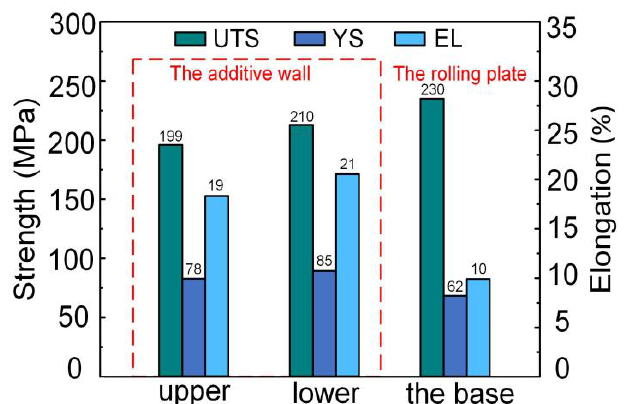
Figure 11. Comparative histogram of mechanical properties of the additive wall and the rolling plate.